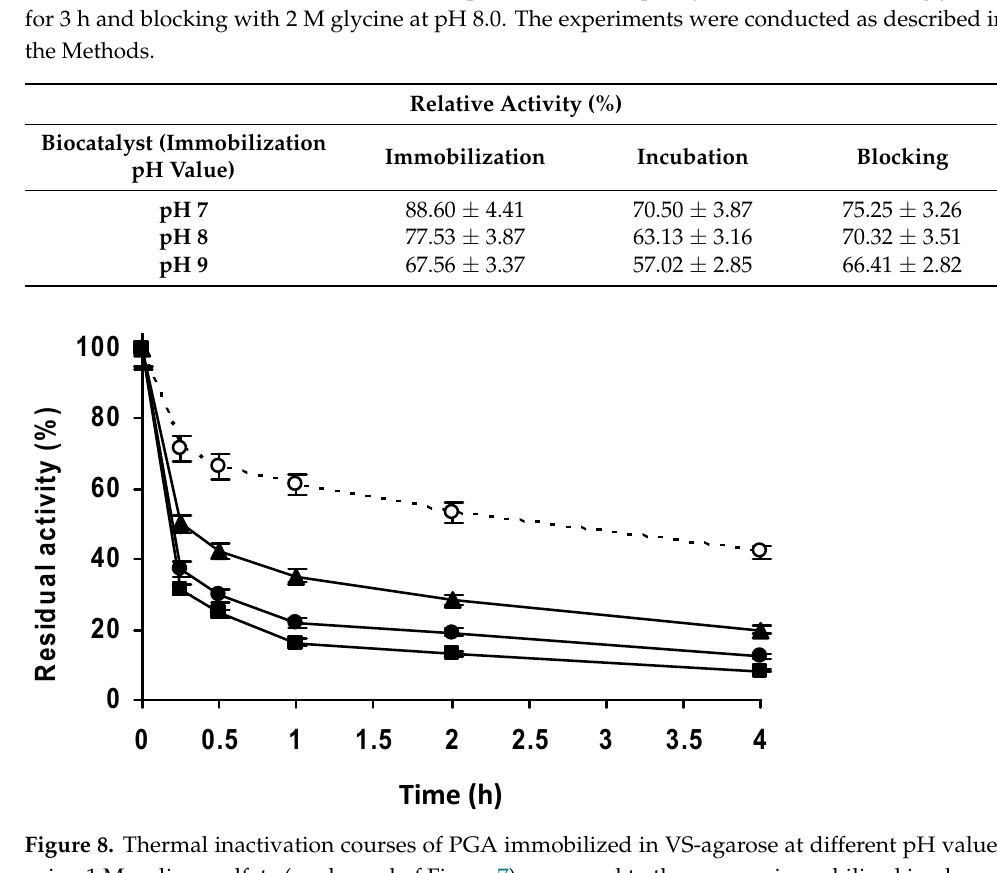
Table 1. Effect of the immobilization pH on the expressed activity of PGA immobilized on VS- agarose. Biocatalysts were immobilized using 1 M sodium sulfate with 50 mM of each buffer; sodium phosphate at pH 7.0, sodium phosphate at pH 8.0 and sodium carbonate at pH 9.0. Incubation was carried out in 50 mM sodium carbonate at pH 9.0 (100 mM phenylacetic acid and 30% glycerol)